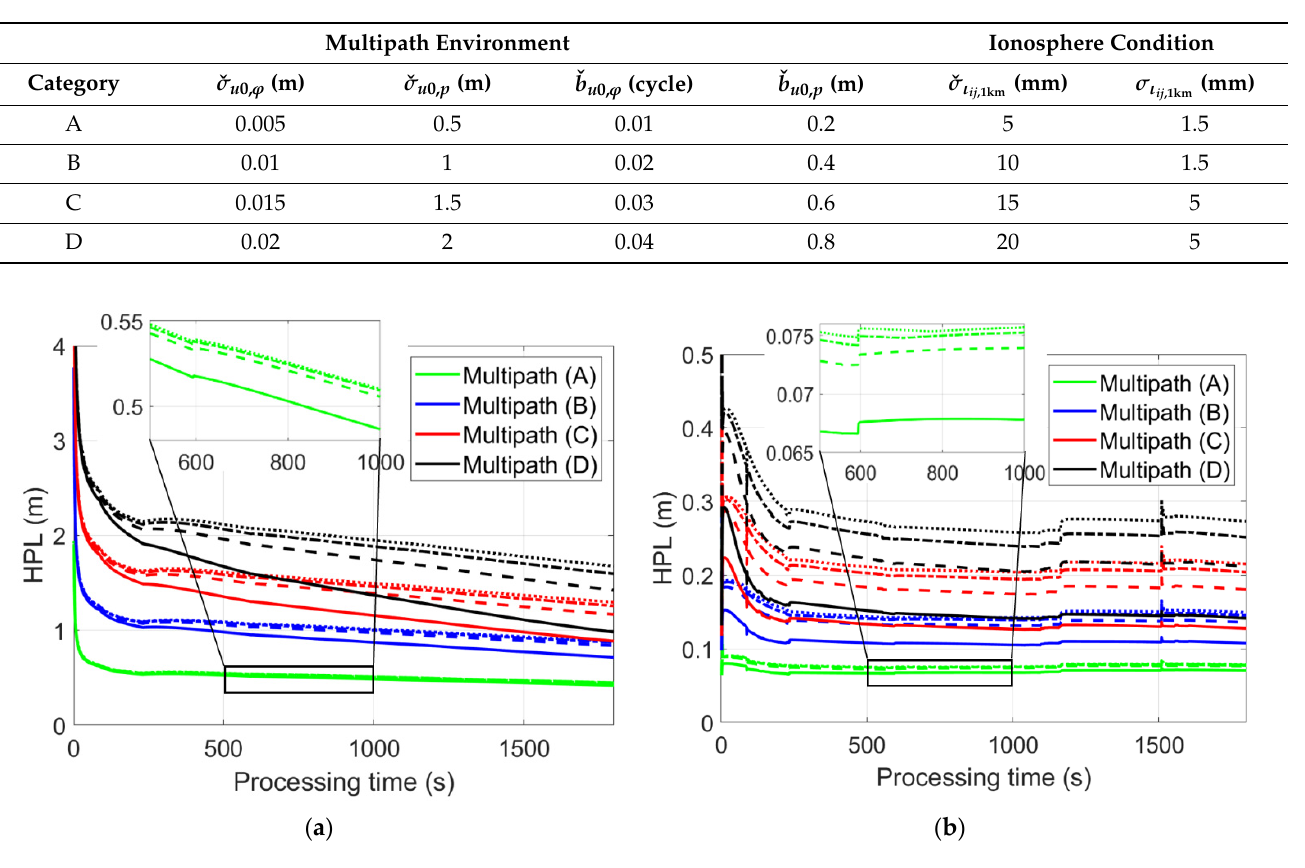
( b ) Figure 10. HPLs of different PMI (cid:2892) under different multipath/ionosphere conditions in: ( a ) the am- biguity-float case; ( b ) the ambiguity-fixed case. The solid, dashed, dashed-dotted and dotted lines represent the PMI (cid:2892) of 2 × 10 (cid:2879)(cid:2871) , 2 × 10 (cid:2879)(cid:2872) , 2 × 10 (cid:2879)(cid:2873) and 2 × 10 (cid:2879)(cid:2874) , respectively.